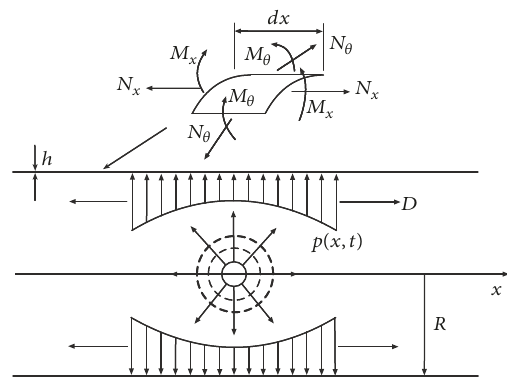
Figure 1: A cylindrical shell under blast loading from a centric point-source